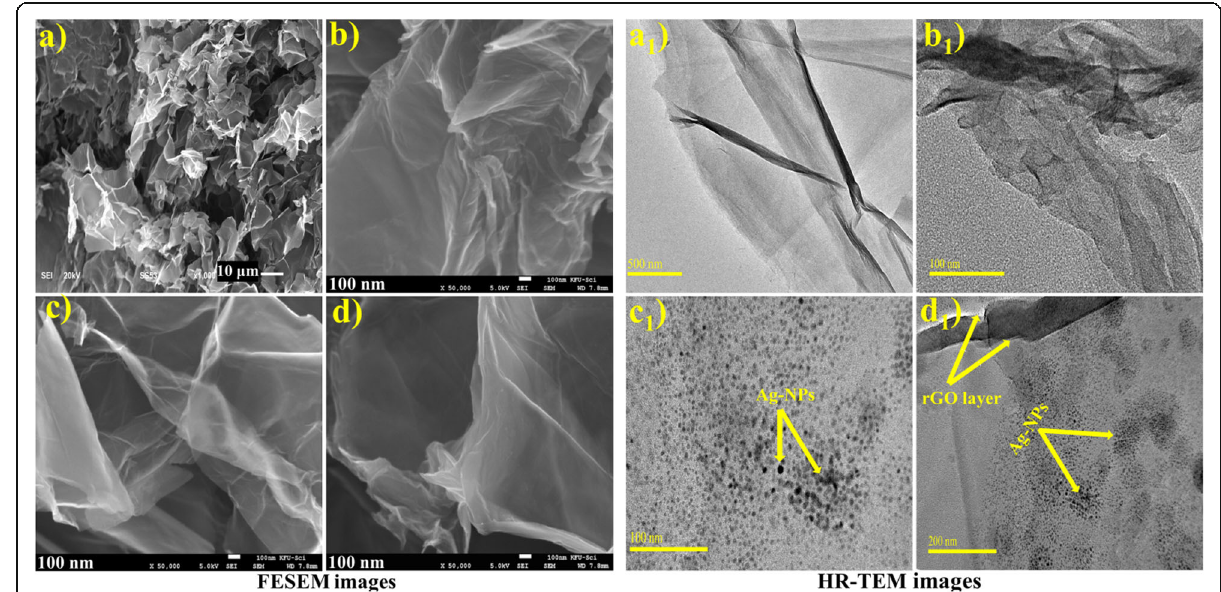
Fig. 5 ( a - d , a 1 - d 1 ) FESEM and HR-TEM images of GO and Ag/rGO ( a , a 1 ) GO ( b , b 1 ) 0.050:1 ( c , c 1 ) 0.075:1 and ( d , d 1 )